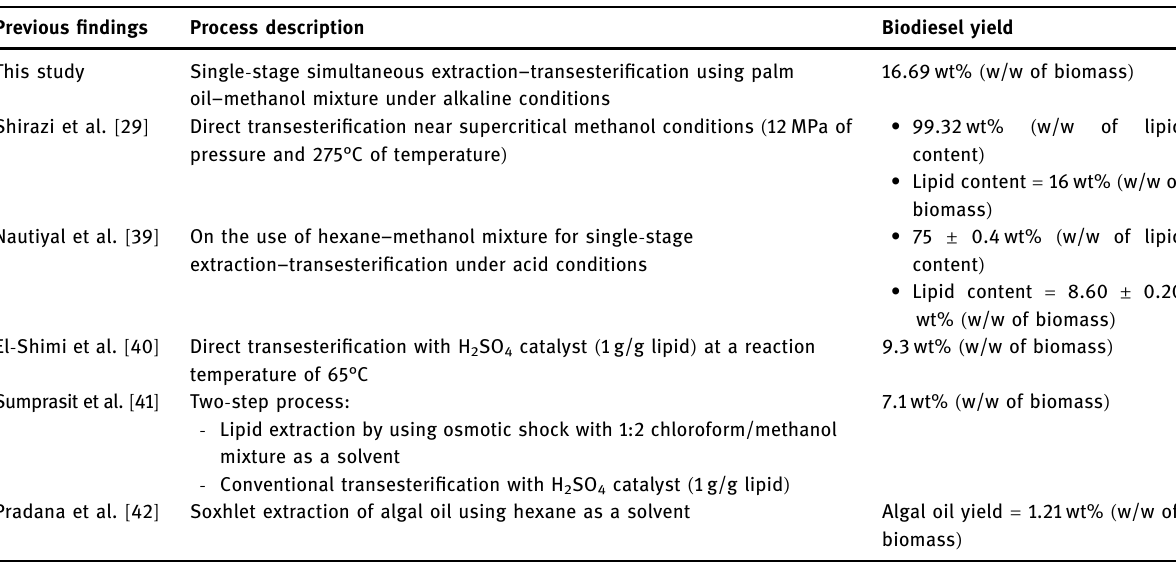
Table 7: Comparison of biodiesel yield from Spirulina